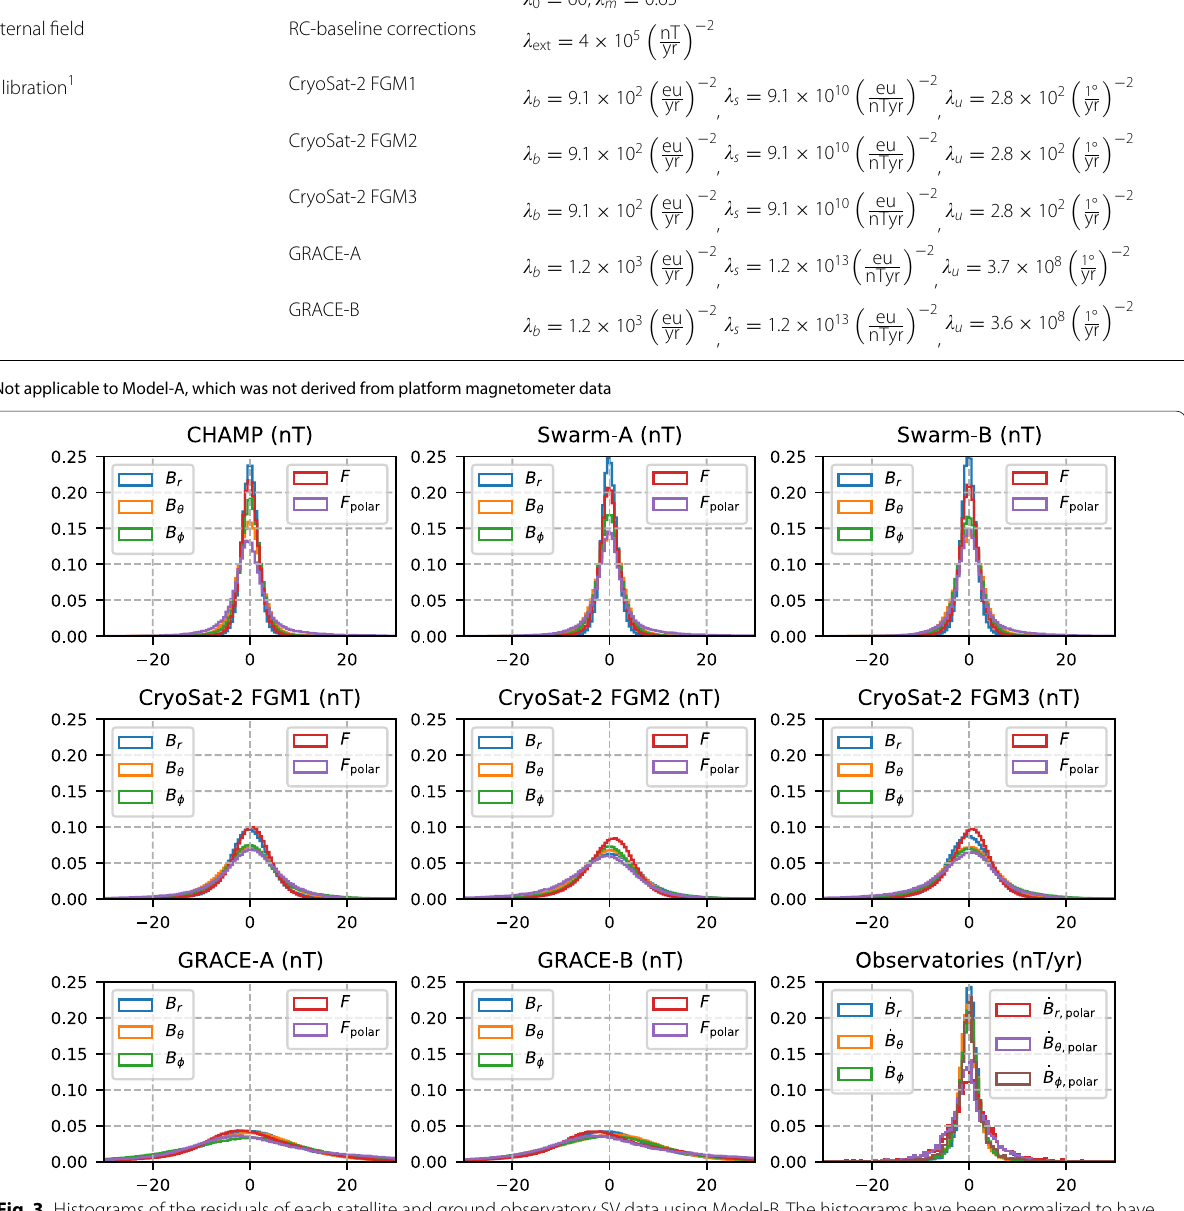
of the test models are given below. The regularization parameters are the same for all the presented models, i.e., Model-A, Model-B, and the test